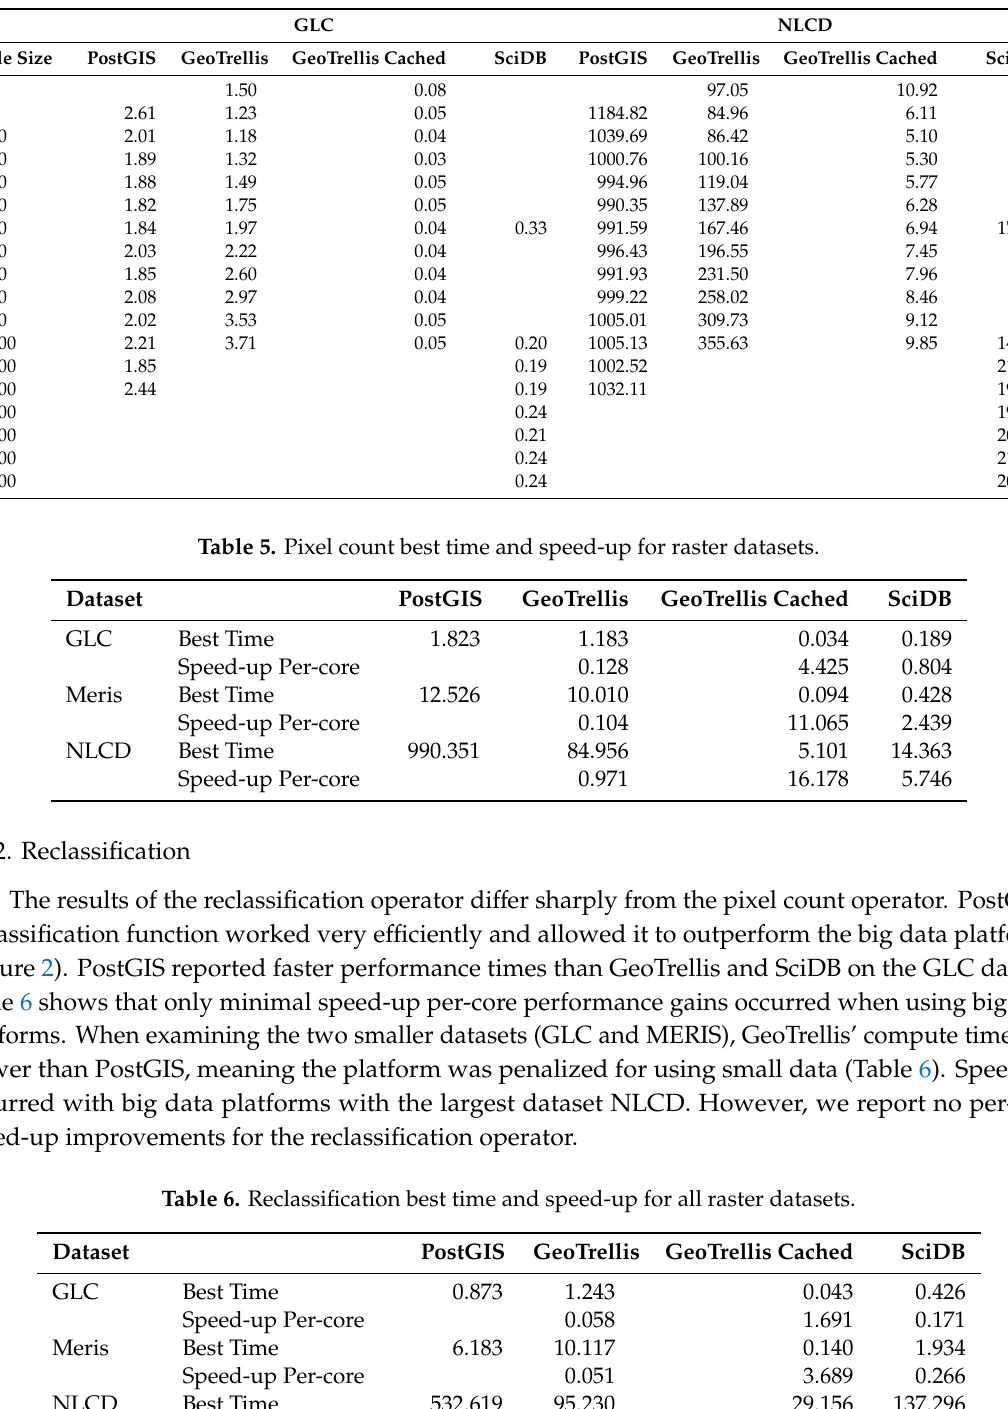
Table 4. Pixel count performance times in seconds on GLC and NLCD datasets by platform.